Question: Which kind of chart has been used to present this data?
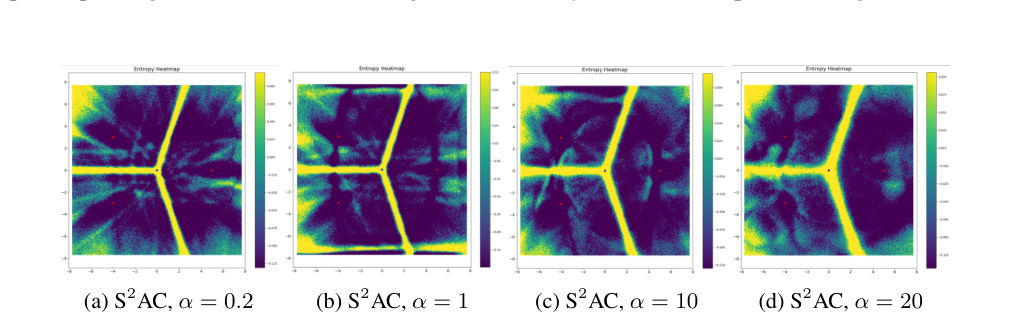
Answer: heatmap